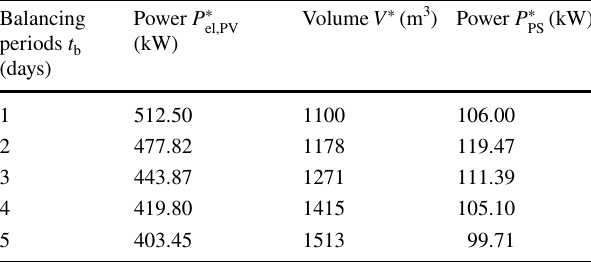
Table 2 Sizes of subsystems for different balancing periods